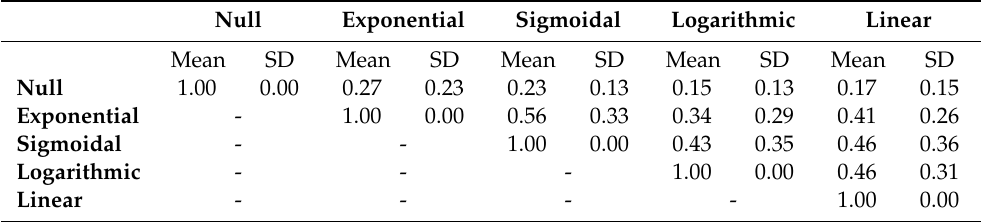
Table 5. Sensitivity analysis results comparing the functional connectivity current maps generated under each resistance scenario. Across species means and standard deviations for the pairwise comparisons of Spearman’s rank correlation coe ffi cient between cells of each current map. Correlation coe ffi cients were calculated by randomly selecting 5% of the cells in the masked study region of each